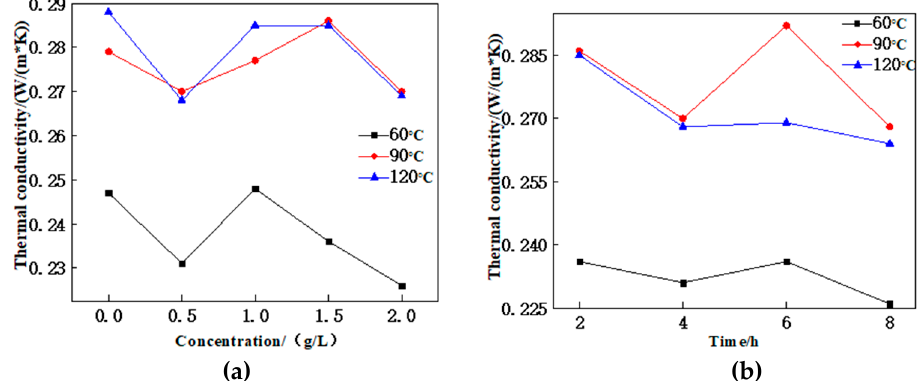
Figure 7. Thermal conductivity of composites: ( a ) effect of CF modified with different concentrations of dopamine on thermal conductivity of composites; ( b ) effect of processing time of dopamine-modified CF on thermal conductivity of composites.